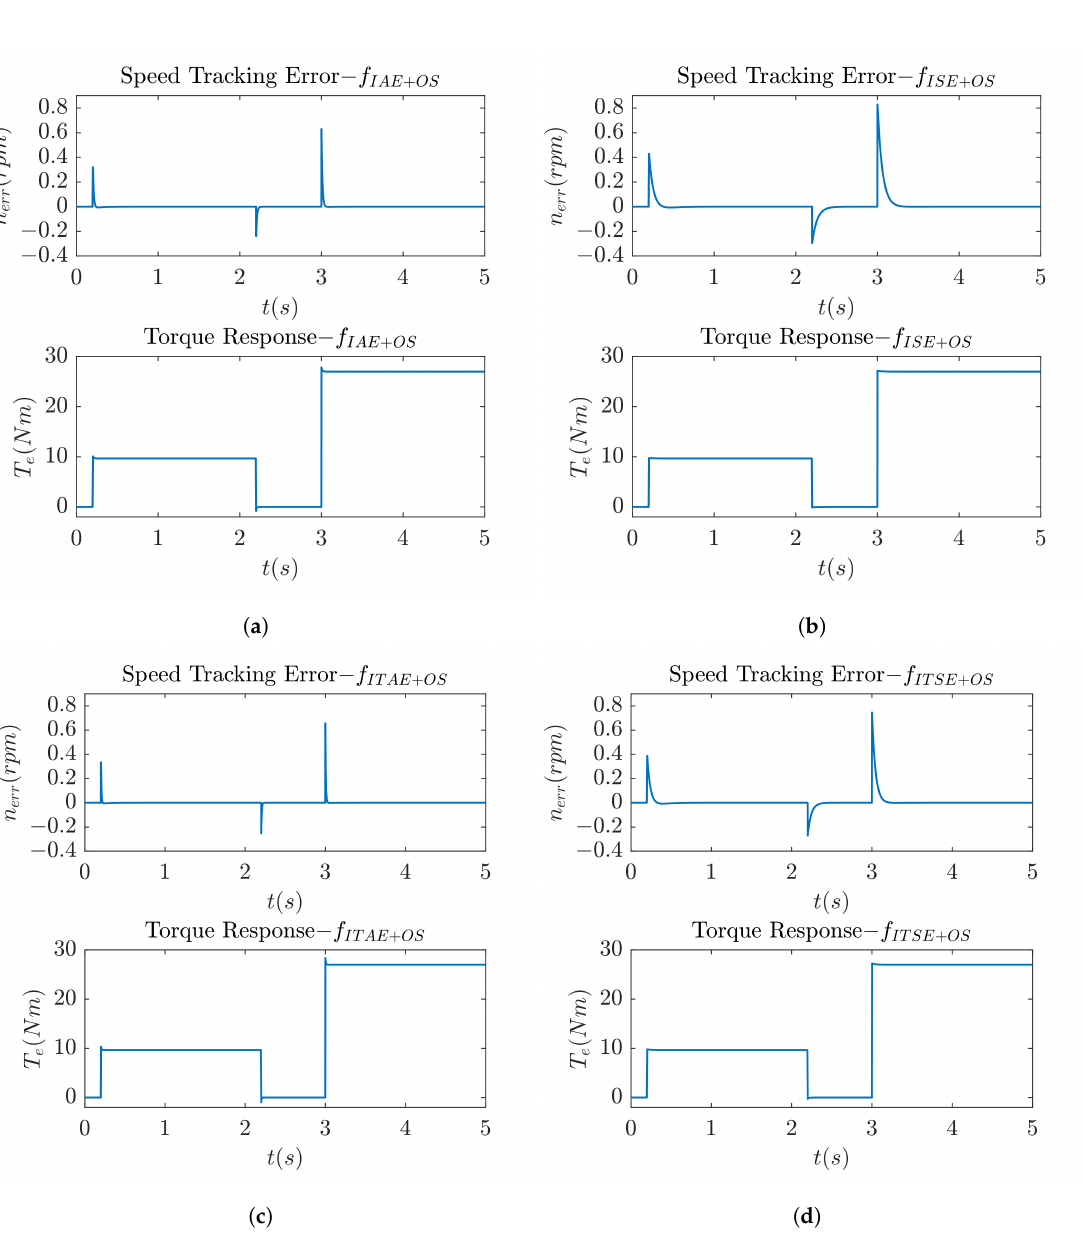
Figure 10. Speed tracking error and torque responses produced by: ( a ) Integral absolute error criterion with overshoot penalization. ( b ) Integral squared error criterion with overshoot penalization. ( c ) Integral time absolute error criterion with overshoot penalization. ( d ) Integral time squared error criterion with overshoot